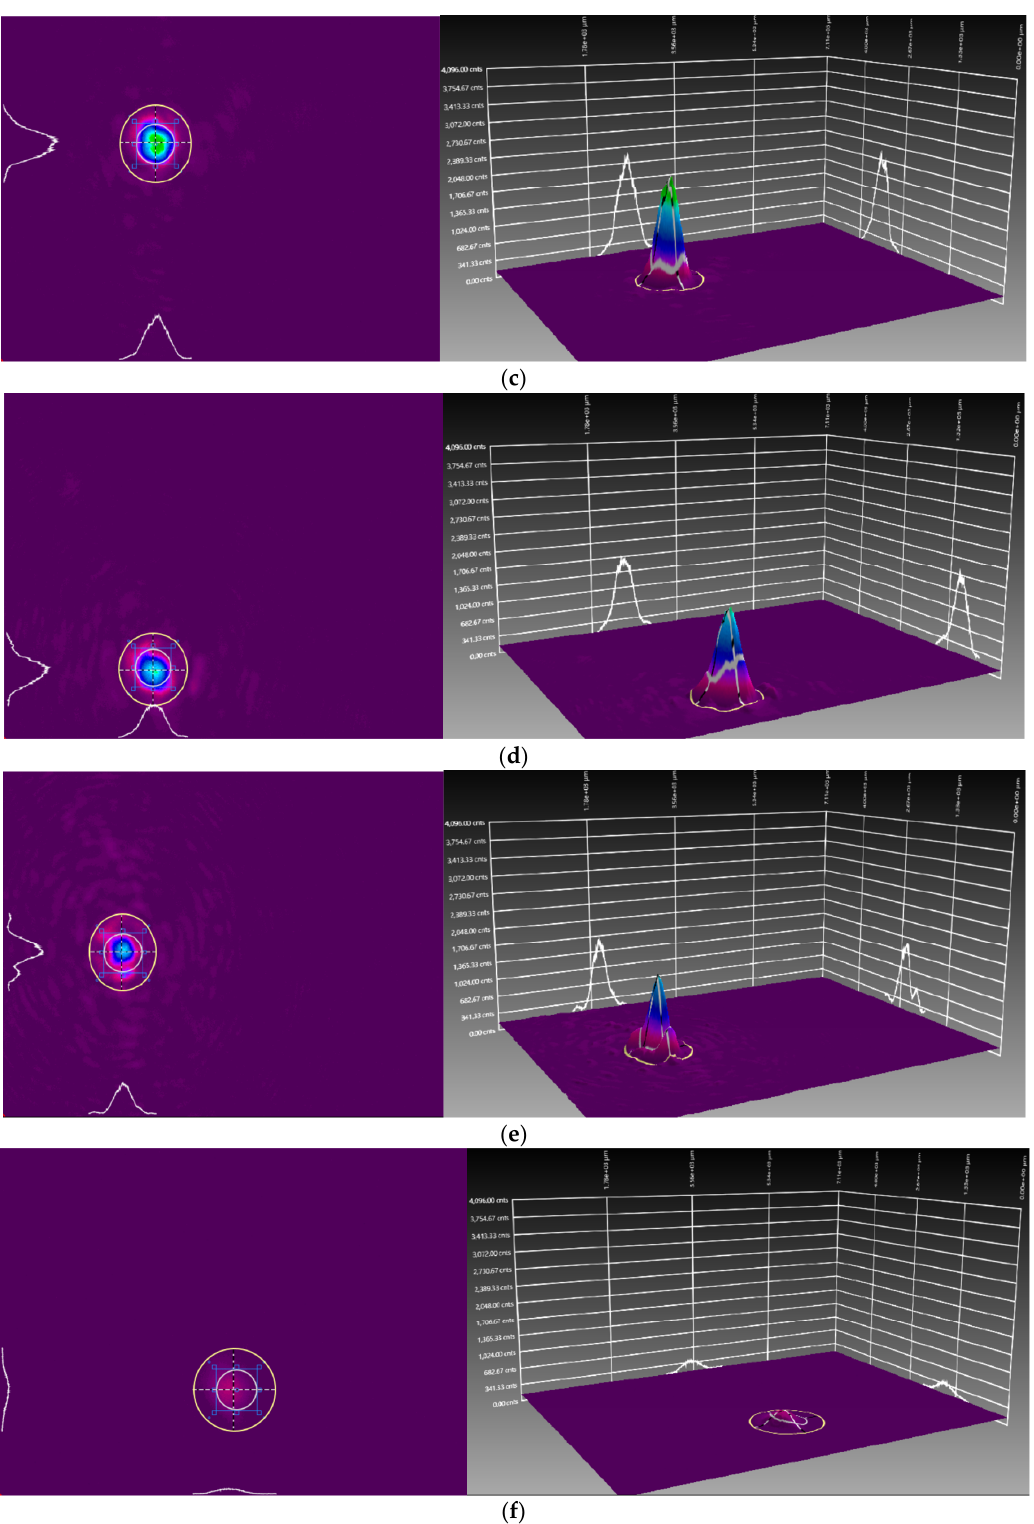
Figure 6. 2D ( left ) and 3D ( right ) diffraction patterns of ( a ) DG-g-PMAA1, ( b ) DG-g-PMAA2, ( c ) DG-g-PMAA4, ( d ) DG-g-PMAA6, ( e ) DG-g-PMAA8, and ( f ) DG-g-PMAA16 for TM polarization at m = 0.